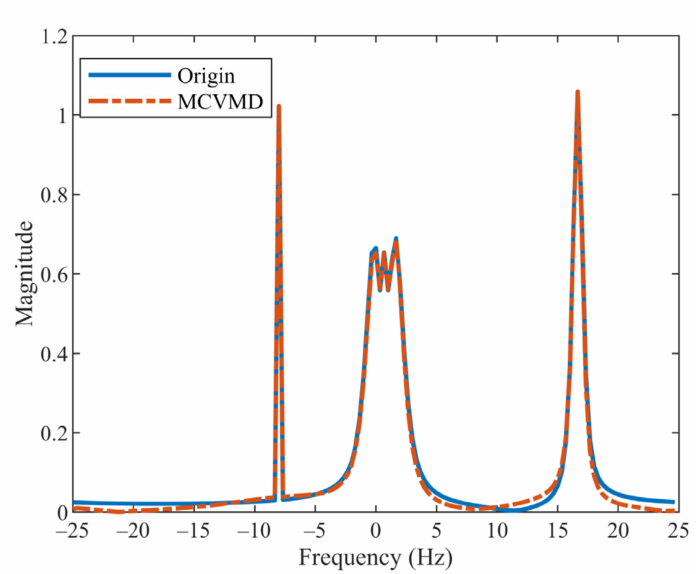
Figure 4. Spectrum of the original signal (blue solid line) and reconstruction signal by MCVMD (red dash-dot